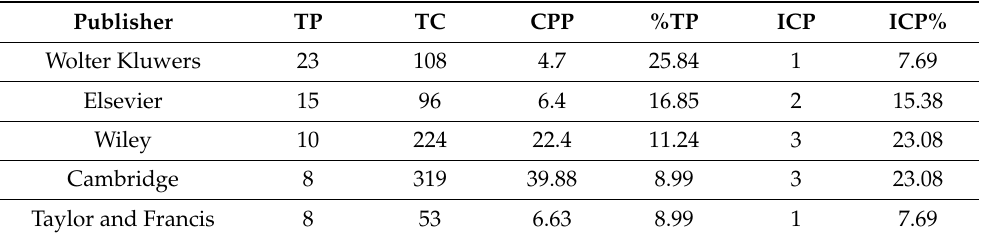
Table 6. The five publishers on dhat syndrome research (n =